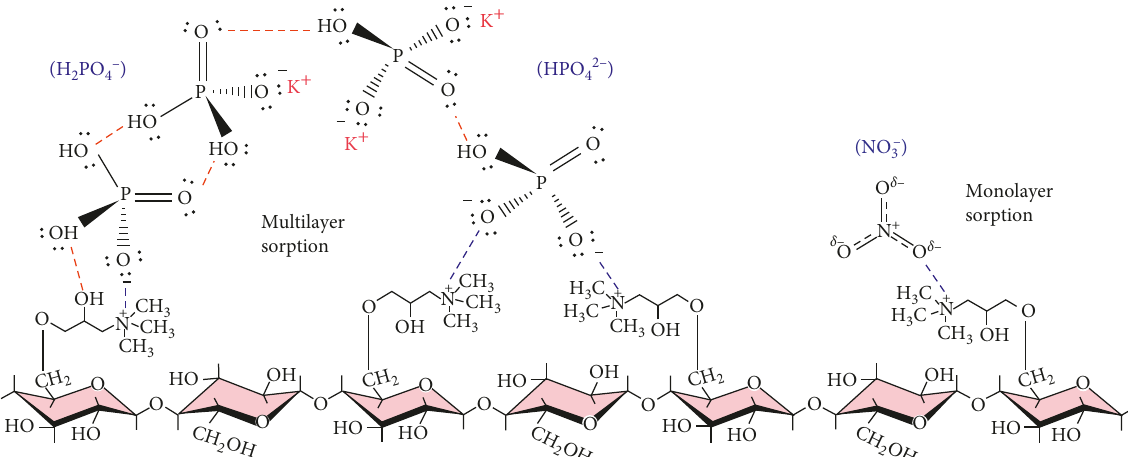
Figure 10: Structural model of the biosorbent after the multilayer sorption of phosphate ions and monolayer sorption of nitrate ions from the aqueous